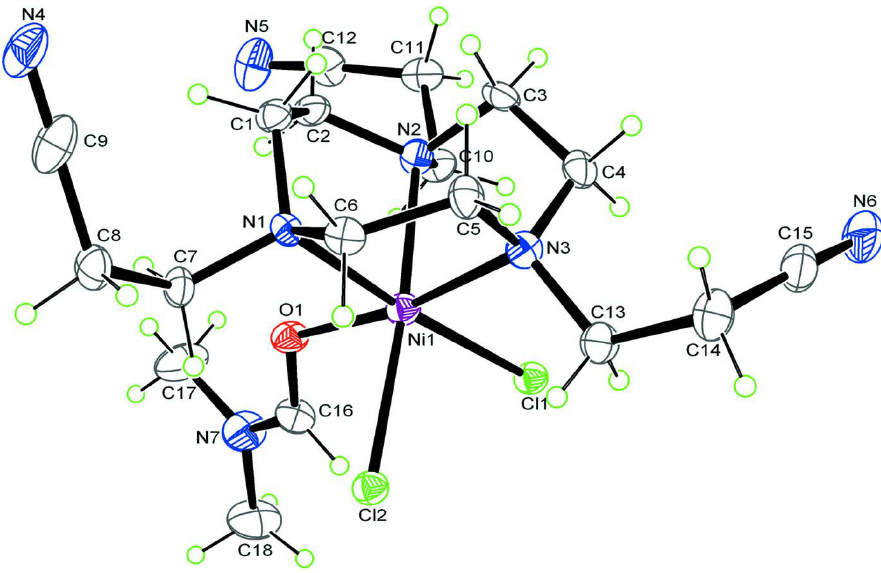
Figure 1 The molecular structure of the title compound, showing displacement ellipsoids at the 30% probability level (arbitrary radii spheres for H atoms).